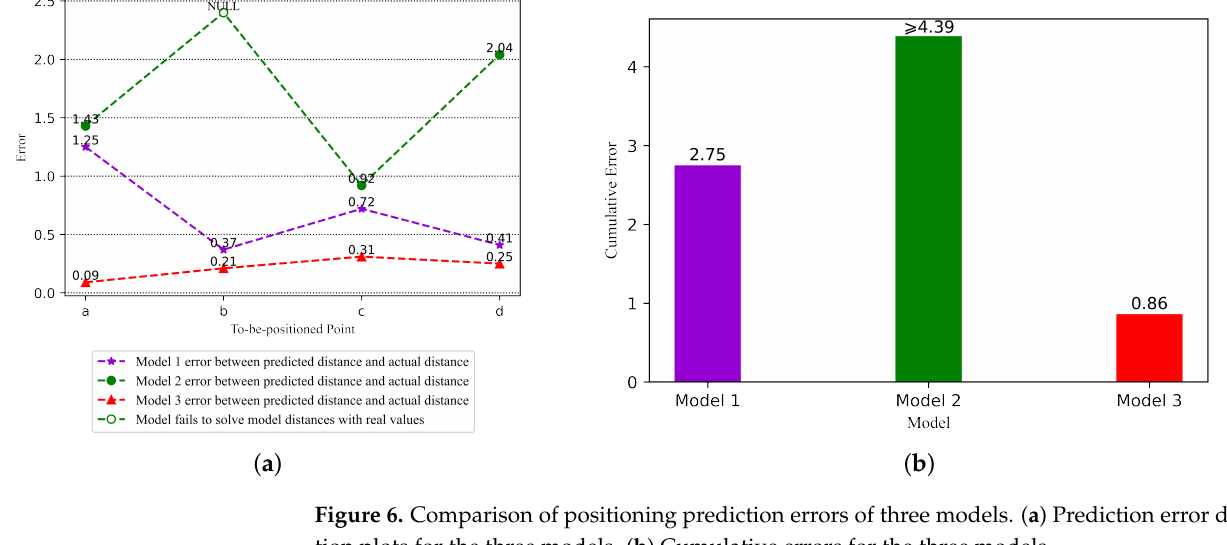
Figure 6. Comparison of positioning prediction errors of three models. ( a ) Prediction error distribu- tion plots for the three models. ( b ) Cumulative errors for the three